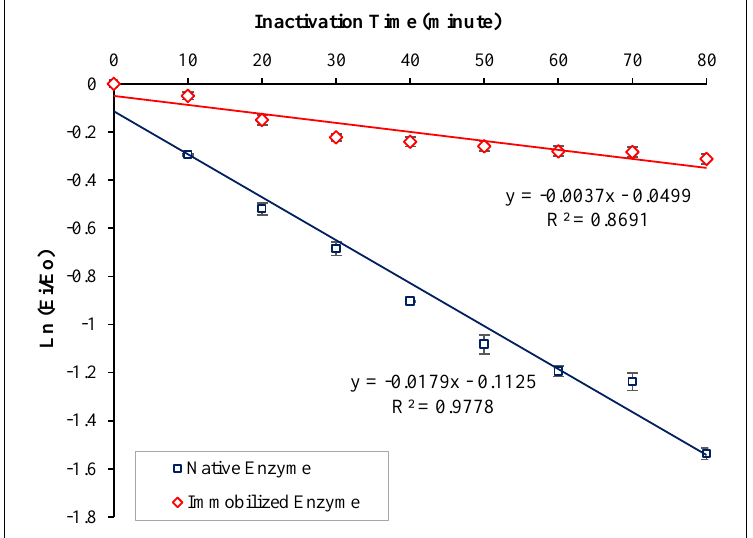
Figure 7. First-order inactivation rate plot of the native and immobilized enzymes at 60°C (mean ± SD; n = 2; p < 0.05) Table 3. t ½ and ΔG i values for native and immobilized α-amylase in the latest experiments Half-life (t 1/2 ) The transformation of free energy (min) because denaturation (∆G i ) (kJ mole -1 ) Stability Host Enzyme Matrix Improvement